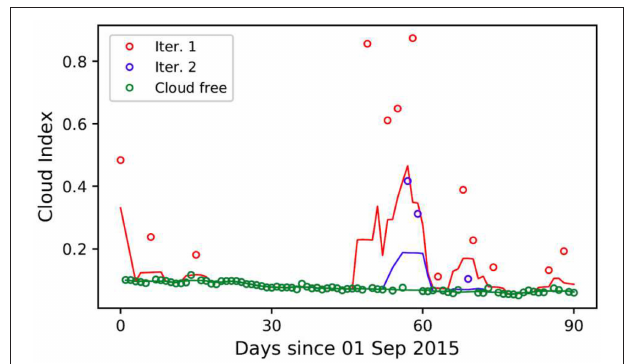
FIGURE 3 | Confidence, c , as function of relative cloud index, i c , for parameters of present work ( C = 15, σ = 1 and I = 3 for cloudy cases or I = 2 for clear cases). Note that for the clear case (in blue) the negative of confidence and relative cloud index are plotted to show the two-way nature of the confidence level. The shaded areas illustrate re-classification using a confidence threshold, c min = − 3 in this plot, which reclassifies some originally clear pixels as cloudy resulting in the reclassified clear pixels with higher clearness